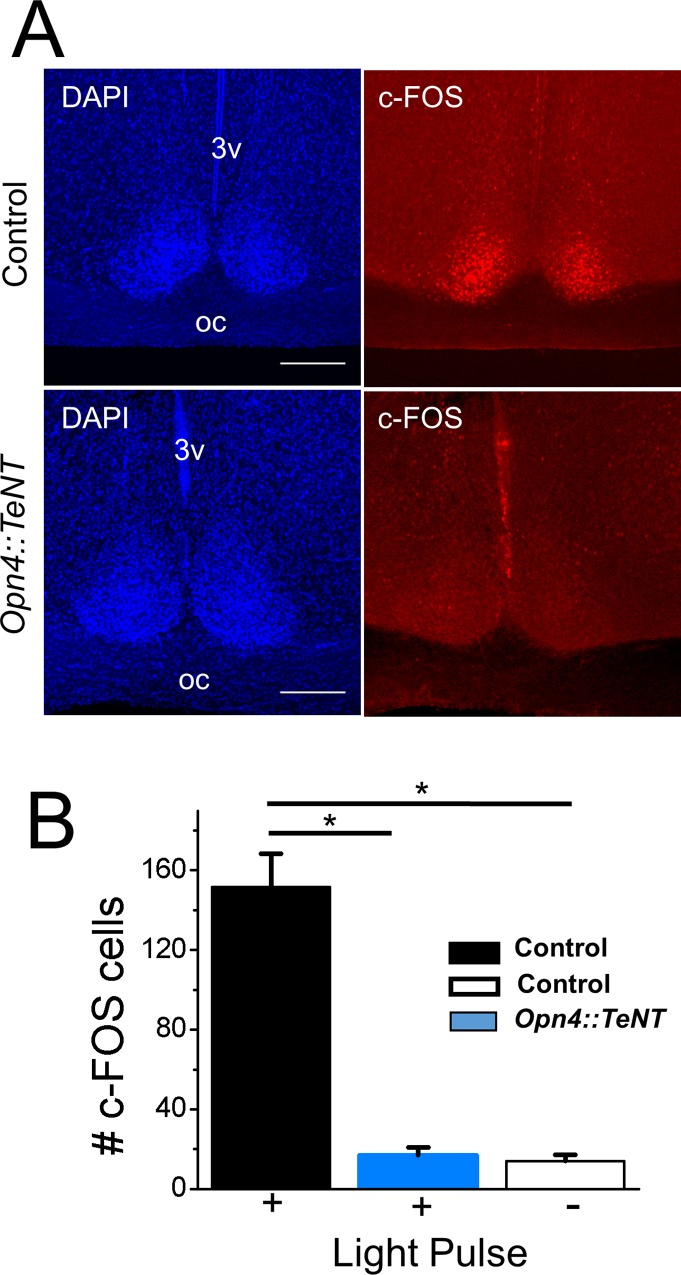
Lack of c-FOS expression in the Opn4::TeNT suprachiasmatic nucleus following light pulse at CT 16.(A) Immunocytochemical staining for c-FOS in the SCN of control and Opn4::TeNT mice exposed to a light pulse. Notice the diminished number of c-FOS positive cells in the mutant mouse. Scale bar = 100 um. (B) Quantification of c-FOS expression in the suprachiasmatic nucleus in control mice exposed to a light pulse (+) or no light pulse (-) and in mutant mice exposed to a light pulse. Expression is reflected by the number of c-FOS positive cells per suprachiasmatic nucleus per slice. n = 3–8. *P<0.004 by Kruskal-Wallis non-parametric ANOVA, followed by Dunn’s multiple comparison test.